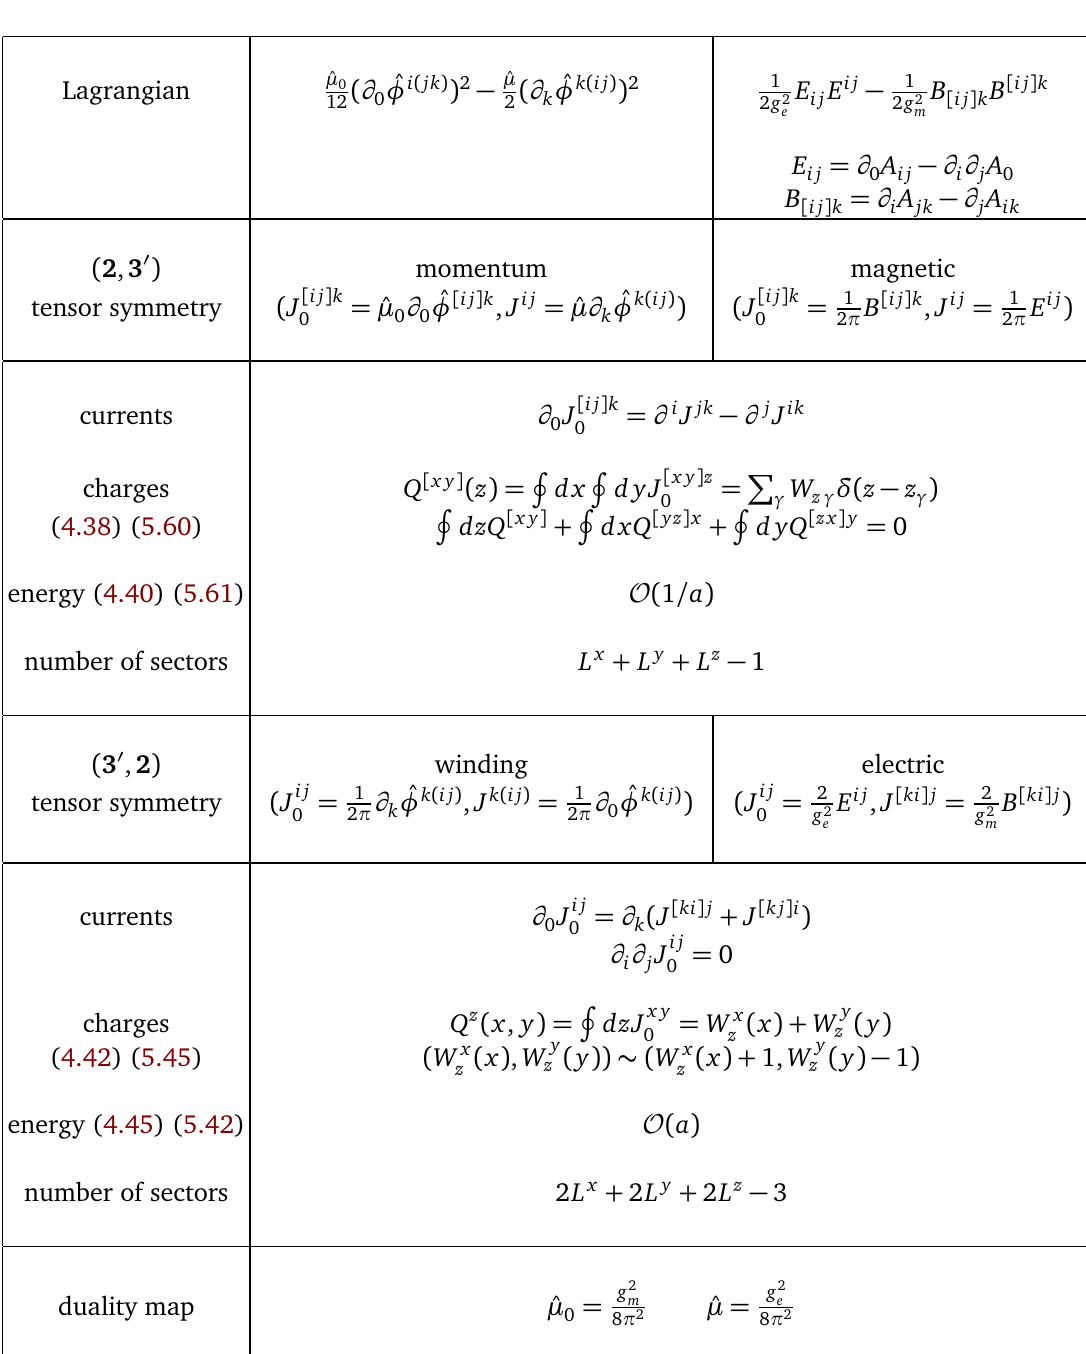
Table 3: Global symmetries of the U ( 1 ) tensor gauge theory A and its dual ˆ φ . Above we have only shown charges for some directions, while the others admit similar ex-